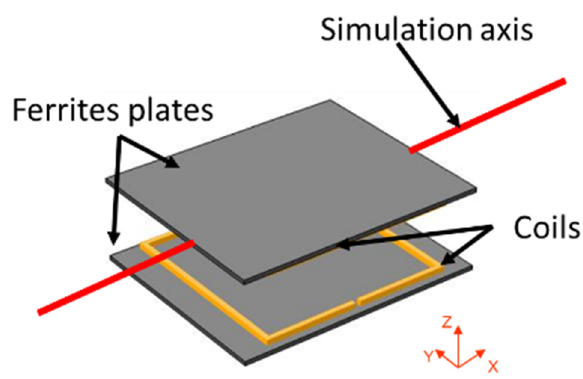
Figure 15. Configuration for emission simulation.